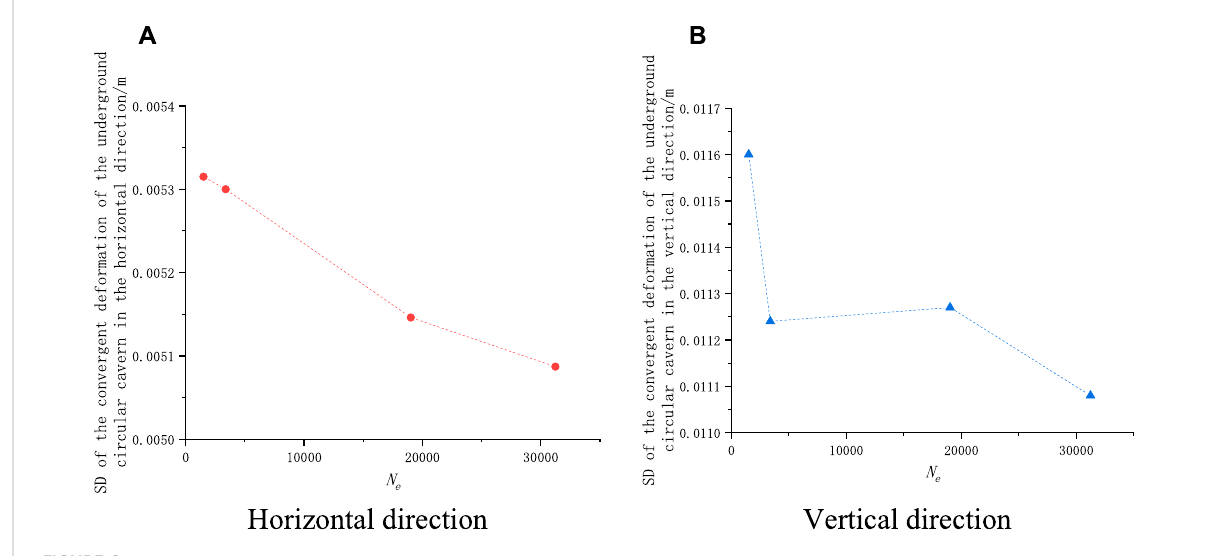
FIGURE 8 Standard deviation of convergence deformation with different numbers of elements. (A) Horizontal direction. (B) Vertical direction.